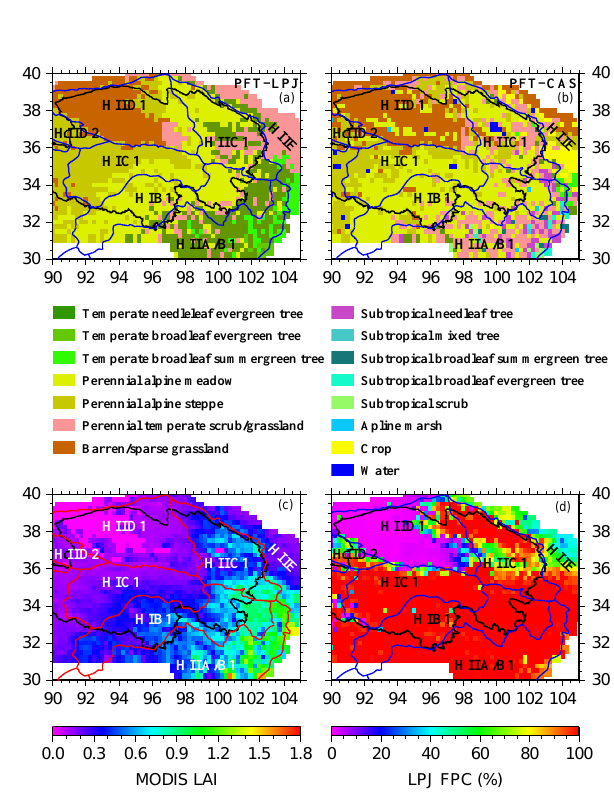
Figure 4. Eco-geographic regions from Zheng et al. (2008) (blue lines in a , b , d and red lines in c ) and the LPJ simulated dominant plant functional types represented by foliar projective covers (FPCs) under full leaf during 1957–2009 (a) ; Zheng et al. (2008) and CAS (2001) surveyed maps (b) ; MODIS Terra LAI and Zheng et al. (2008) maps (c) ; and LPJ simulated FPC and Zheng et al. (2008) maps (d) . The eco-geographic regions are the following: HIIC1: plateau temperate semi-arid high mountain and basin coniferous forest and steppe region; HIID1: plateau temperate arid desert re- gion; HIID2: plateau temperate high mountain arid desert region; HIC1: plateau sub-cold semi-arid alpine meadow-steppe region; HIB1: plateau sub-cold sub-humid alpine shrub–meadow region; HIIA/B1: plateau temperate humid/sub-humid high mountain and deep valley coniferous forest region; and HIIE: temperate shrub grass-desert region. Black line outlines the Qinghai Province.